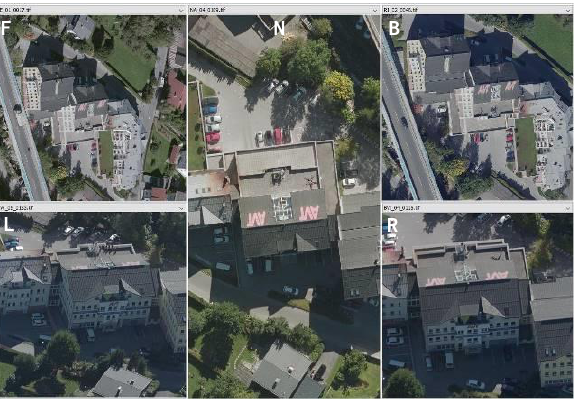
Figure 3. Similarity of B/F and L/R Osprey images from different strips. Zoom on AVT building in Imst. Visualization in the GEOBLy tool.